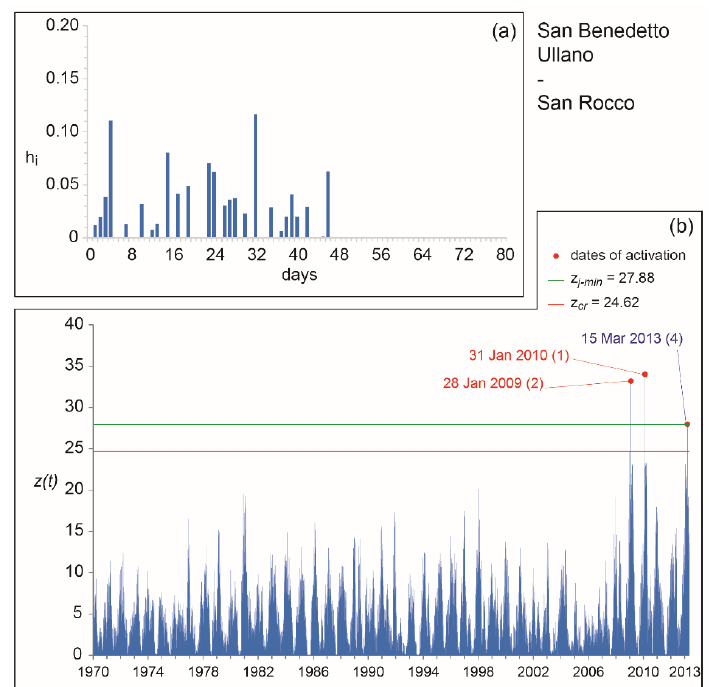
Figure 8. San Benedetto Ullano—San Rocco case study: ( a ) optimal kernel; ( b ) mobility function obtained by applying the optimal kernel to the entire set of available activation dates (cf. [54,64]).